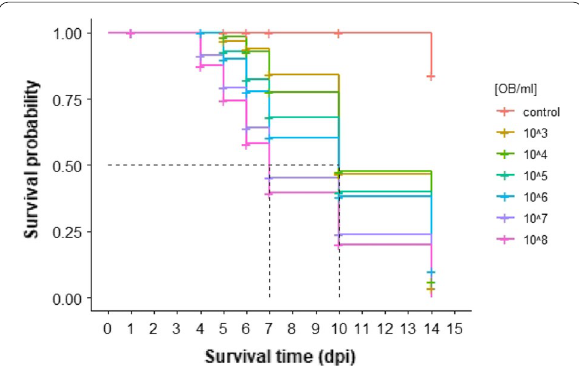
Fig. 1 Kaplan–Meier survival analysis of Spodoptera littoralis L3 larvae infected with different concentrations of SpliNPV-Tun2, ranging from 10 3 to 10 8 OB/ml. The untreated control is given as an orange line. Each line contains three independent replicates with 25 larvae each. Survival time is given in days post-infection (dpi). Dash lines represent the median survival time (ST 50 ) for high (10 7 and 10 8 OB/ml) and low OB (10 6 OB/ml or less) concentrations